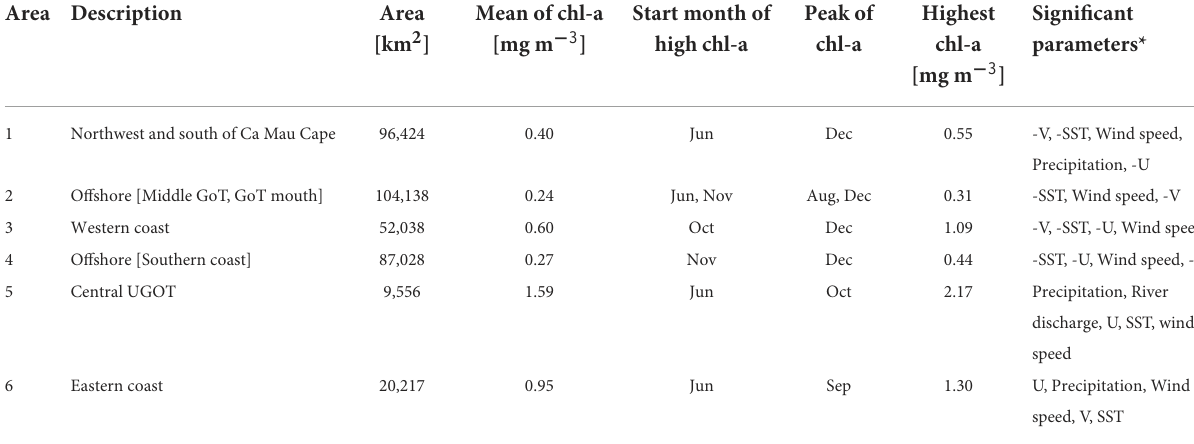
TABLE 2 Summary of chl-a variability in the GoT.